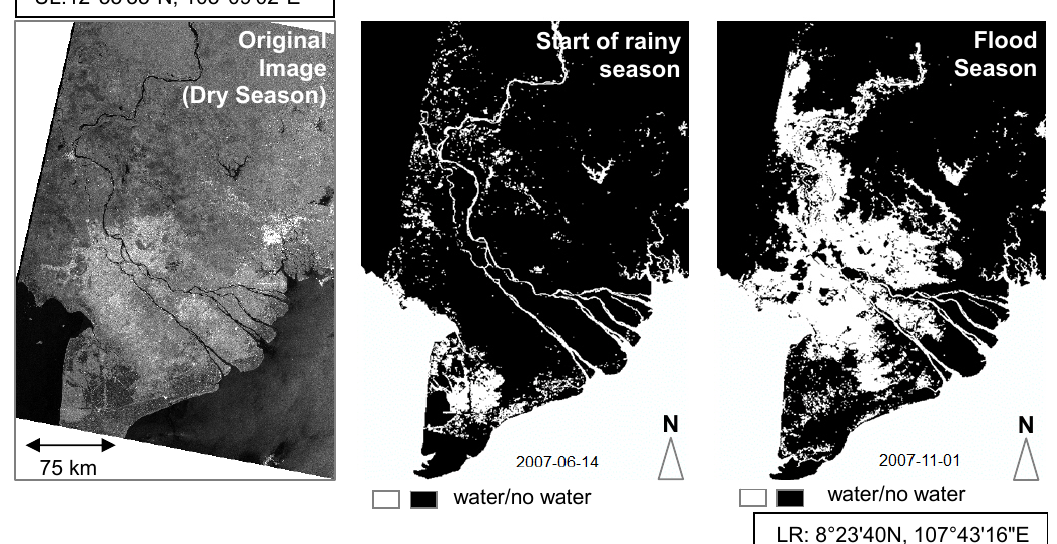
Figure 3. Original Envisat ASAR WSM image of 2007-06-14 ( left , all images were georectified using the ESA software BEAM), and derived water mask of 2007-06-14 ( middle ). Difference between the start of the rainy season ( middle ), (where still a lot of the rain water infiltrates into the soil or runs off into rivers and canals) and the flood peak around the end of the rainy season ( right ). Extent: UL: 12°N, 104°15'E, LR: 8°30'N, 106°50'E (Source: Kuenzer et al .